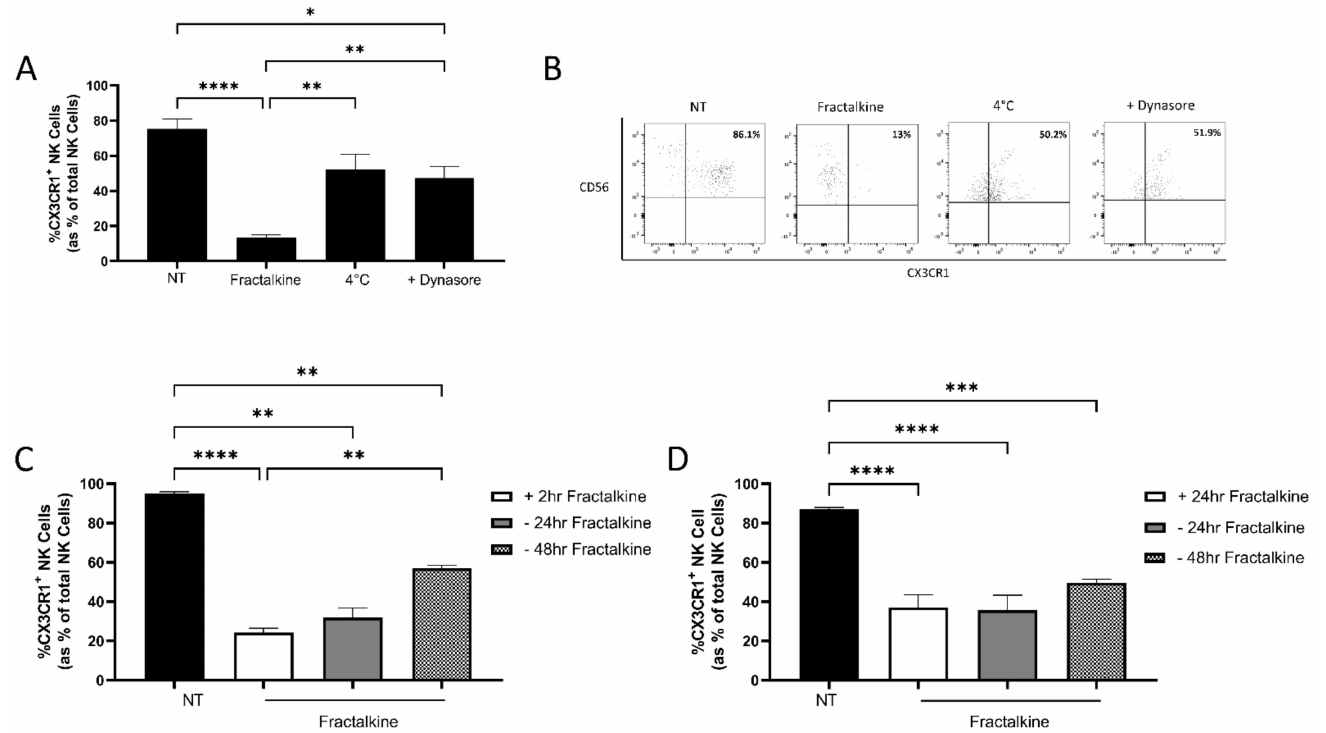
Figure 1. Fractalkine mediates endocytosis of CX3CR1 in NK cells. ( A ) Bar chart showing the frequencies of CX3CR1 + NK cells as a percentage of total NK cells following no treatment (NT), treatment with 30 ng/mL of recombinant fractalkine for 2 h alone, in combination with 80 µ M of dynamin inhibitor Dynasore or at 4 ◦ C. ( B ) Representative dot plots showing peripheral blood derived CX3CR1 + NK cells previously gated on total lymphocytes following no treatment (NT) or treatment with fractalkine for 2 h alone, at 4 ◦ C or in combination with dynasore. ( C ) Bar chart showing the frequencies of CX3CR1 + NK cells as a percentage of total NK cells following no treatment (NT), treatment with fractalkine for 2 h (white) and following removal to a fractalkine-free environment for 24 h (grey) or 48 h (check). ( D ) Bar chart showing the frequencies of CX3CR1 + NK cells as a percentage of total NK cells following no treatment (NT), treatment with fractalkine for 24 h (white) and following removal to a fractalkine free environment for 24 h (grey) or 48 h (check). One way ANOVA, * p < 0.05, ** p < 0.01, *** p < 0.001, **** p <